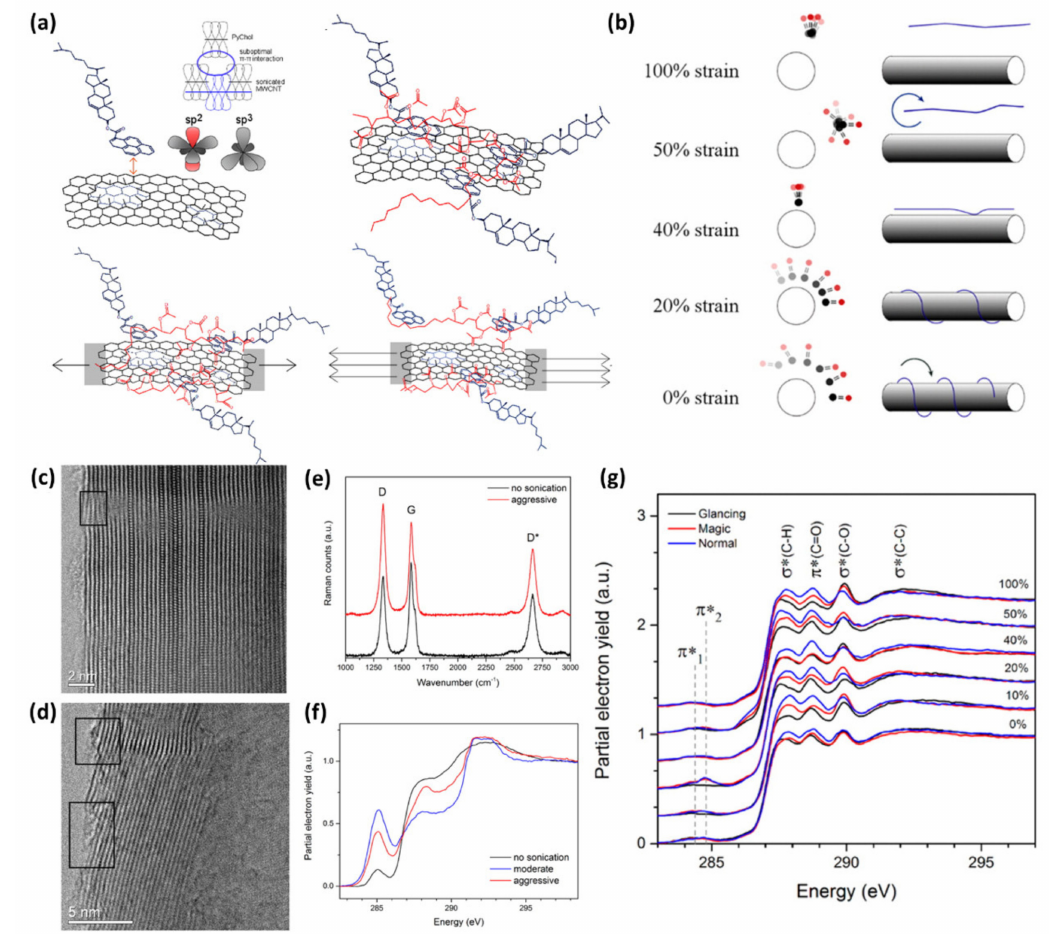
Figure 17. ( a ) Schemes showing the interaction of PyChol to carbon nanotube in ethylene-vinyl acetate (EVA) matrix at low or high strain. ( b ) “Stick and slip” mechanism with the increase in strain. ( c ) TEM images of non-sonicated and ( d ) sonicated multiwall carbon nanotubes (MWCNTs). ( e ) Raman spectra of non-sonicated and aggressively sonicated MWCNTs. ( f ) NEXAFS spectra of non-sonicated, moderately sonicated, and aggressively sonicated MWCNTs. ( g ) Angle-resolved C(1s) K-edge NEXAFS spectra with the increase in strain applied to the nanocomposite. (Reproduced with permission from Reference [133]; Copyright (2015) American Chemical